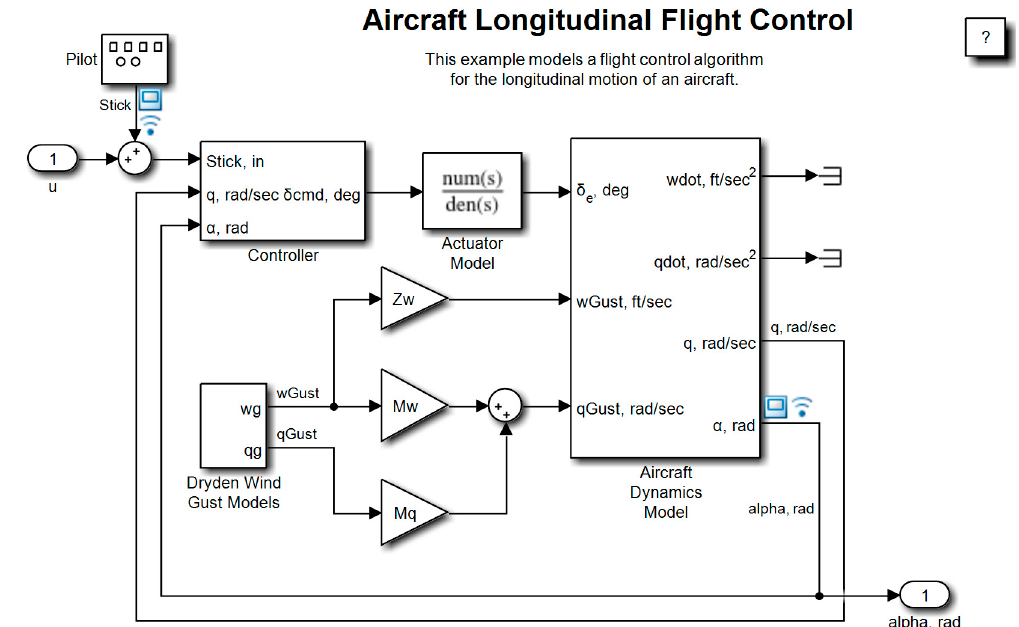
Figure 13. Aircraft longitudinal flight control simulation diagram.